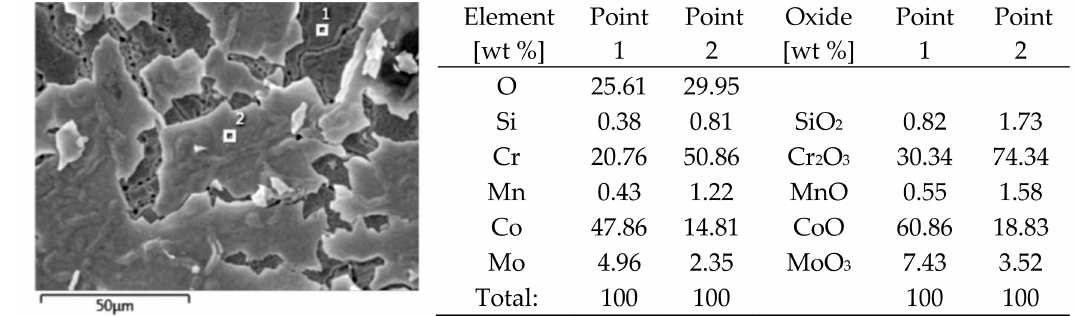
Figure 13. Results of EDS point analyses for the SLM1 sample after corrosion examinations.